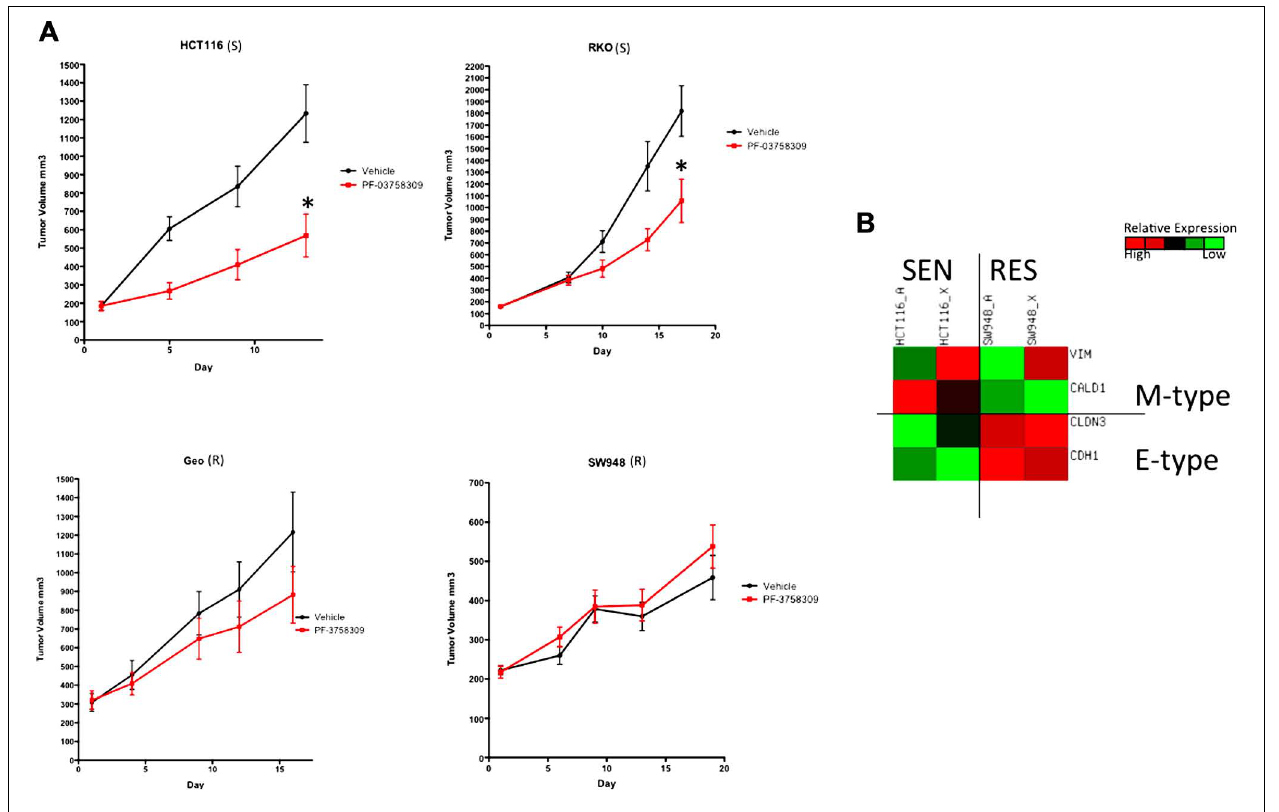
FIGURE 6 |Antiproliferative effects of PF-3758309 in cell line xenografts. (A) Two sensitive and two resistant cell lines in vitro were implanted into athymic nude mice to confirm sensitivity in vivo . (B) Overall the EMT